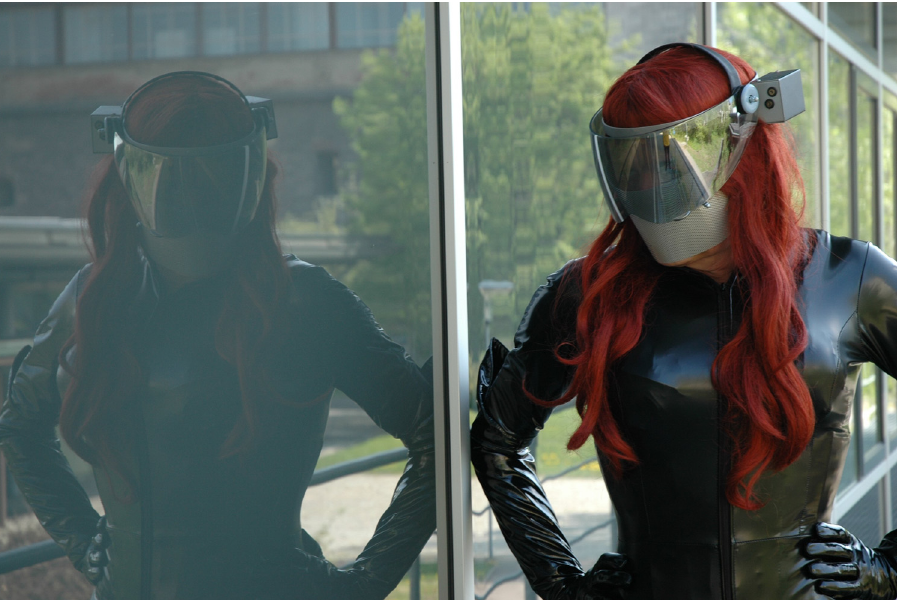
Figure 18: PVC catsuit worn over vibrator bodysuit.